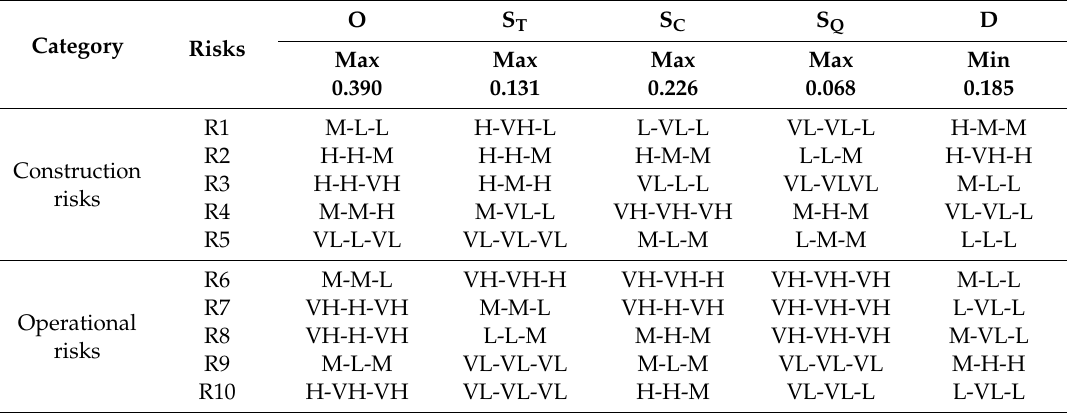
Table 7. Evaluation of experts in linguistic variables for risks in first